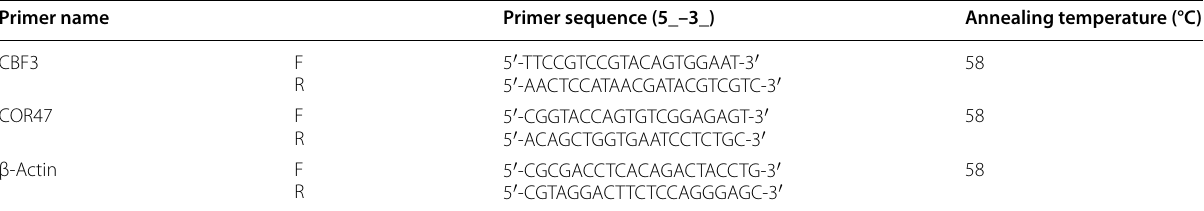
Table 1 The sequences of the primers used in